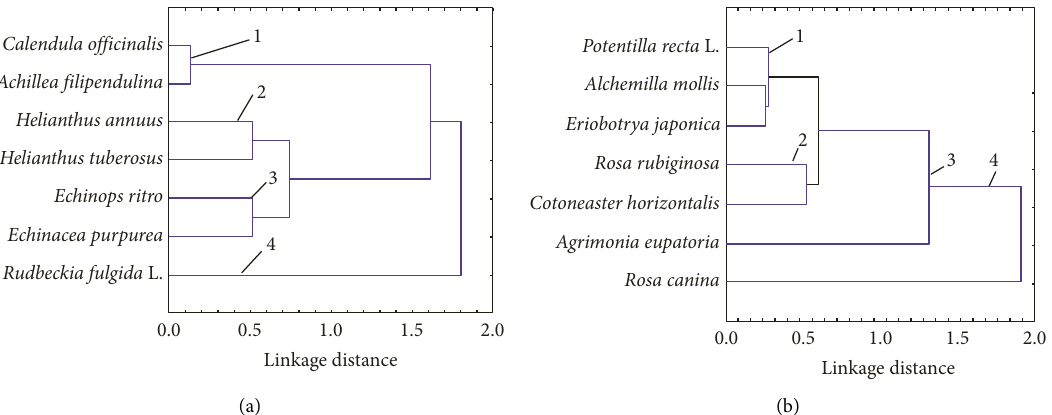
Figure 6: Dendrogram of the species family Asteraceae (a) and Rosaceae (b) obtained after applying hierarchical cluster analysis to the phenolic acids contents using Euclidean coefficient and WARD methods. 1, 2, 3, and 4 clusters. The similar composition of phenolic acids inside of each